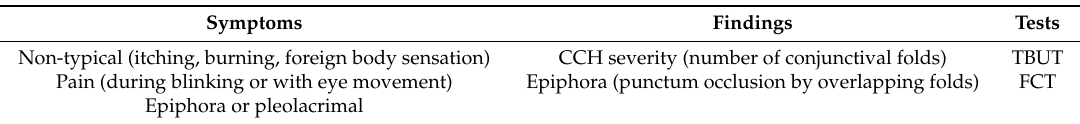
Table 1. Patient’s data documented on clinical examination.